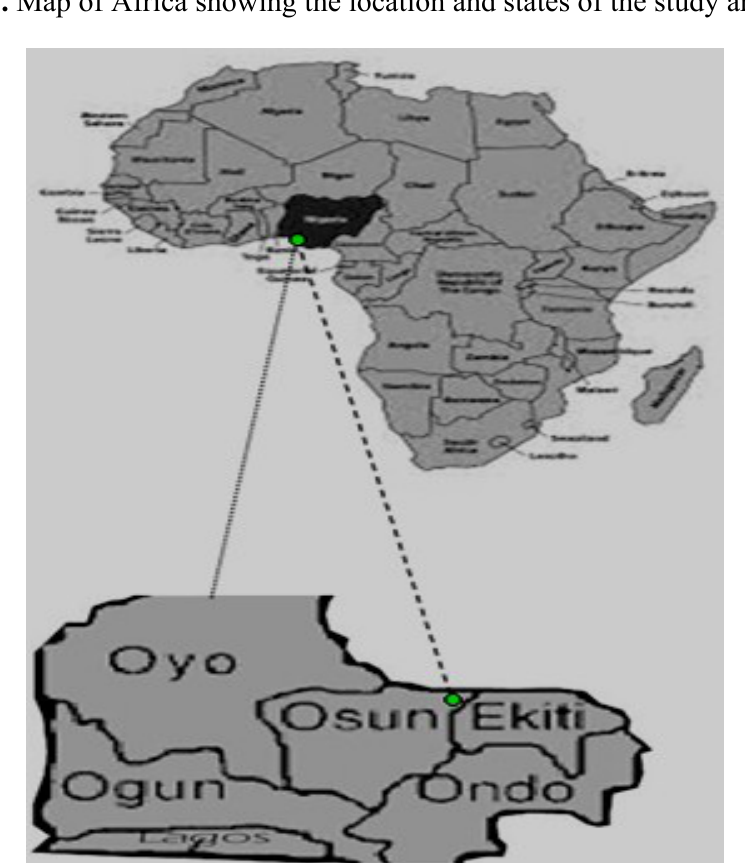
Figure 1. Map of Africa showing the location and states of the study areas